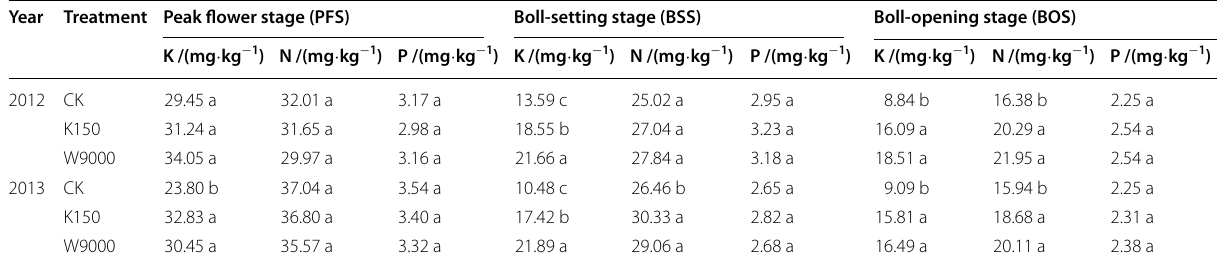
CK, no crop straw and K fertilizer were applied as the blank control treatment; K150, 150 k W9000, 9 000 kg ha − 1 wheat straw was crushed and incorporated in 0 · are significantly different at P 0.05. Each value represents the mean of three replications =